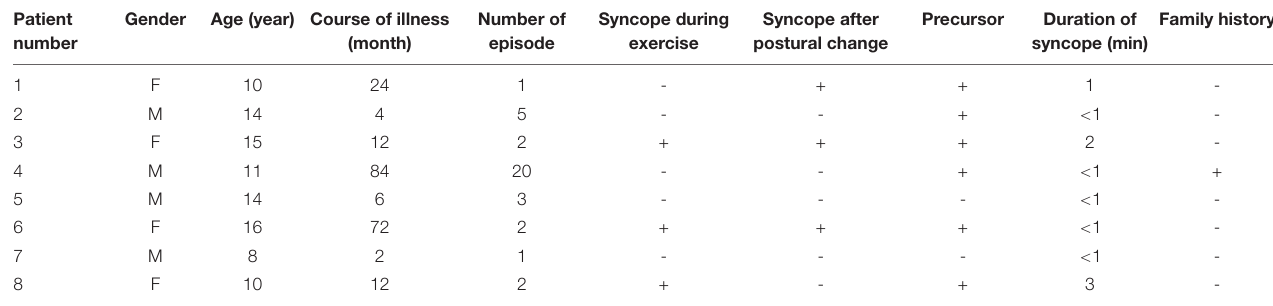
TABLE 1 | Clinical history and